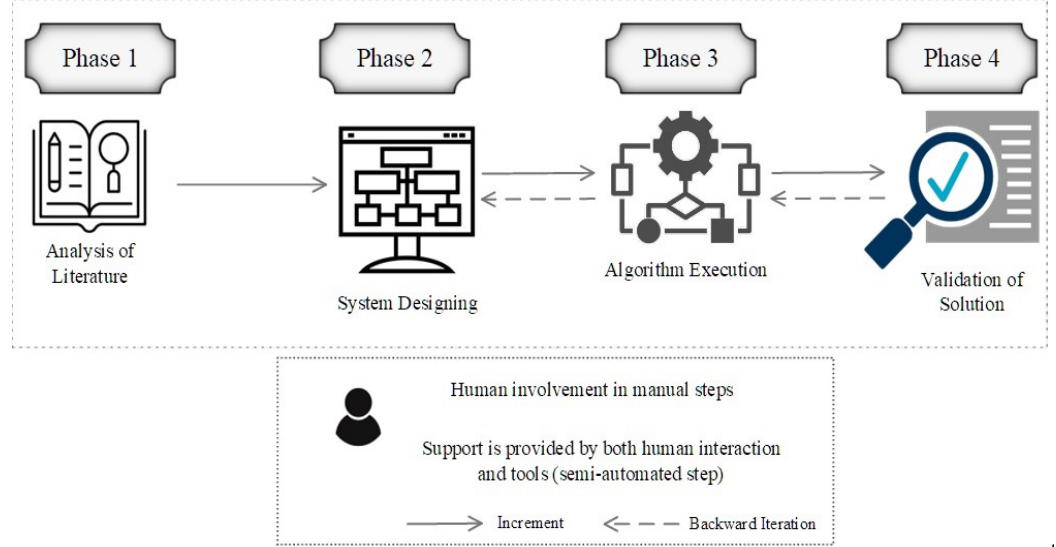
Figure 2. Research Methodology Overview.